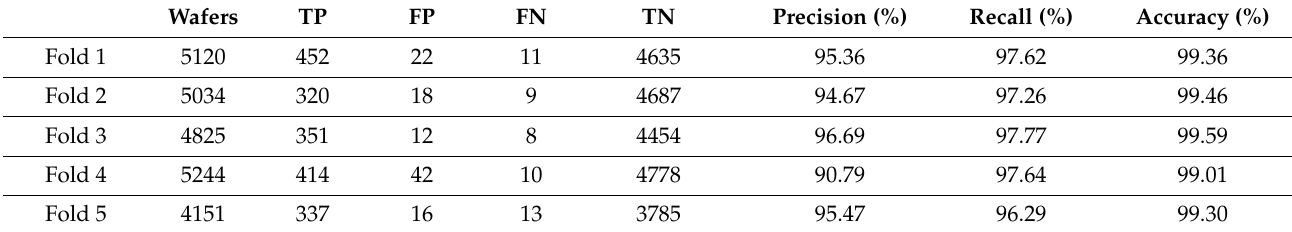
Table 2. Cross-validation test